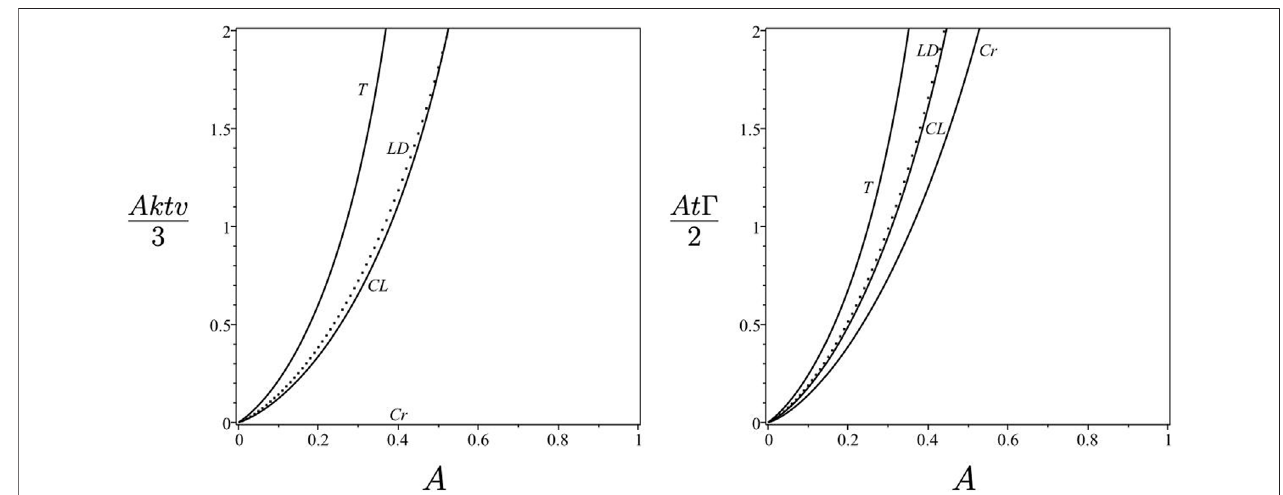
FIGURE 11 | Velocity and shear function as functions of the Atwood number for the critical (Cr), convergence-limit (CL), Taylor (T) and Layzer-drag (LD) spikes for kG (cid:1)